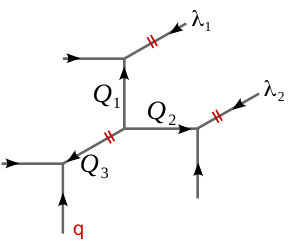
Figure 6 . The direction of the arrows determines the way partitions enter the vertex factor. Partitions are counted clockwise to the preferred direction and the variables t; q enter the vertex factor in this order if t is associated with the end of the (cid:12)rst edge and q with the end of the second.